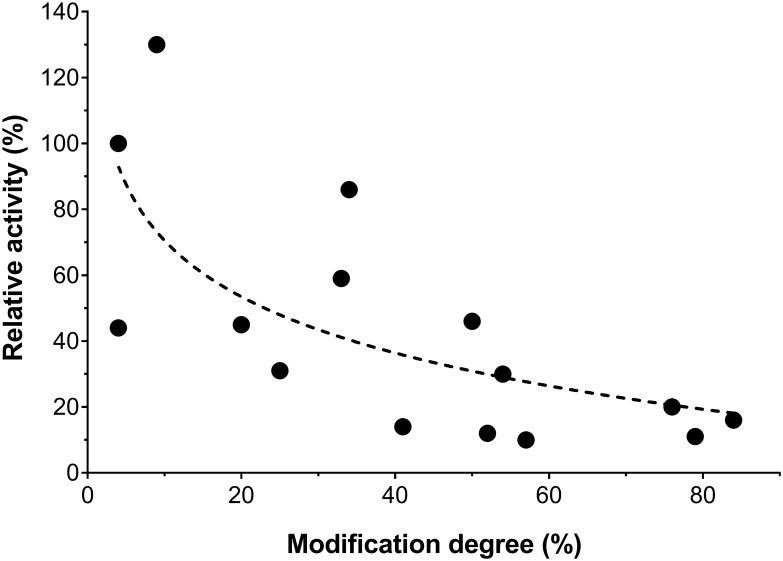
Dependence of L-asparaginase catalytic activity on the degree of PEGylation.Relative catalytic activity is expressed as percentage compared to the non-conjugated L-asparaginase defined as 100% and reported by each study. Modification degree refers to the average percentage of conjugated sites relative to the available amine groups per L-asparaginase tetramer. The results to generate this figure were extracted from references [16–22,34] and this work.